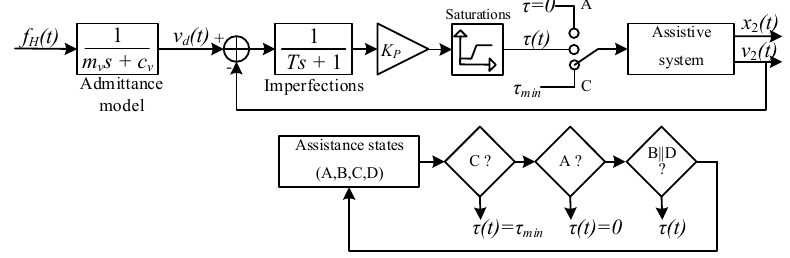
Figure 11. Control loop system with the selection of the torque to apply on the actuator.